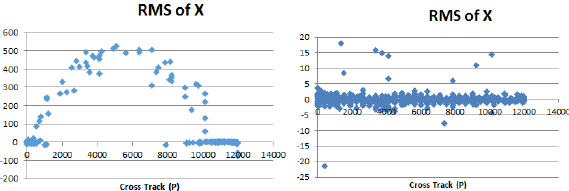
Since those commercial products are distributed with vendor- computed RPC files (referred as to the original RPC), the models to be compared are an original RPC and a computed RPC. The reference imagery is a mosaic from ZY-3 TLC Nadir orthos (at 2m ground resolution with 3m accuracy at average) Figure 1 HJ-1 A/B RMS of X cross track for the scene of HJ1A- generated CCD2-19-72-20130411. Left -- by the simulated Toutin model; Right – by the computed RPC